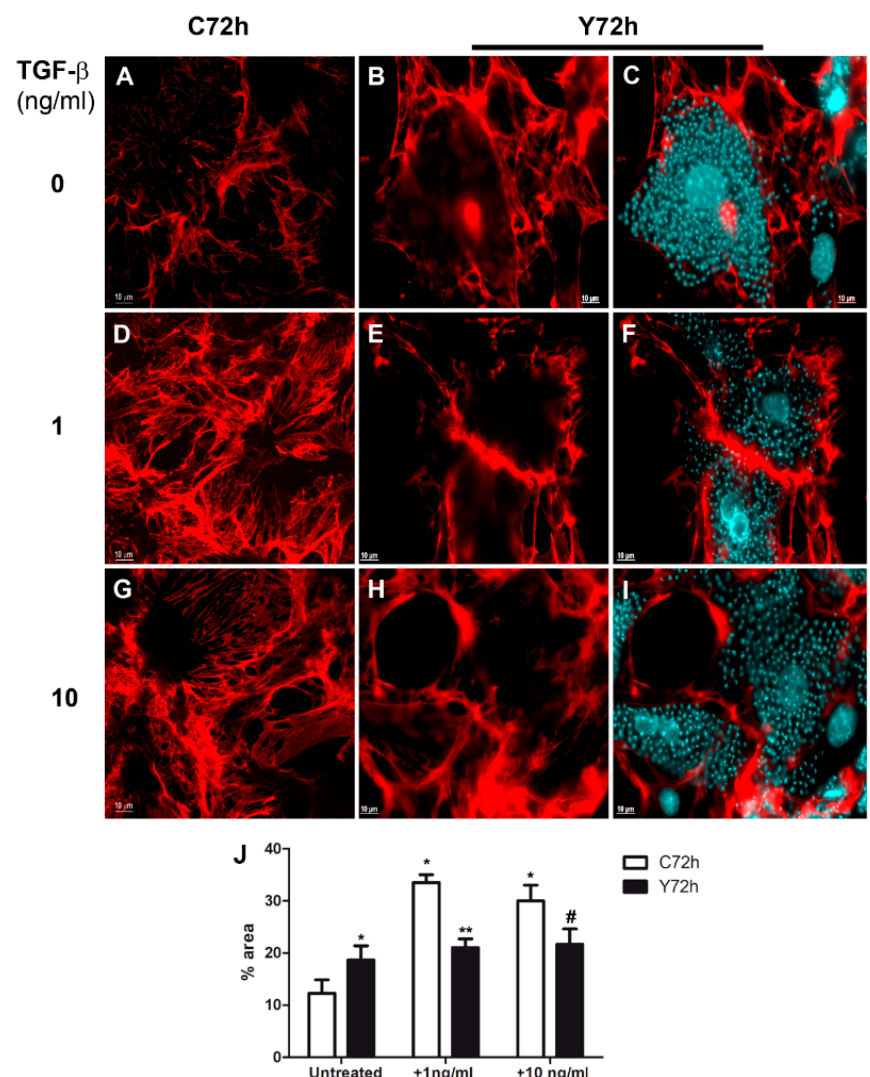
Figure 5. Distribution of fibronectin in cardiac fibroblasts infected with T. cruzi and treated with TGF- β . FN staining (red) in untreated T. cruzi infected CF ( B , C ) showed a general intensification of FN expression after 72 h of interaction, while highly infected cells presented a localized reduction when compared to uninfected controls ( A ). CF cultures showed higher FN expression after treatment with 1 ng / mL ( D ) and 10 ng / mL ( G ) of TGF- β . CF still displayed a localized reduction of FN staining in infected cells, even after TGF- β treatment (( E , F ) 1 ng / mL; ( H , I ) 10 ng / mL). ( J ) Quantification of FN fibril thickness by image processing with Image J software. DAPI (blue) was used to label the nucleus of the host cell and the kinetoplast of intracellular parasites. * p ≤ 0.05 vs. untreated, uninfected control (C72h); ** p ≤ 0.05 vs. uninfected + 1 ng / mL TGF- β ; # p ≤ 0.05 vs. uninfected + 10 ng / mL TGF- β . Bar = 20 µ m. The association of fibroblasts, the e ff ector cells of fibrosis, with relative down-regulation of FN expression in T. cruzi -infected cells after TGF- β stimulation led us to evaluate (in detail) the regulation of the signaling pathways involved in ECM modulation. We analyzed the activation profiles of PS2, phospho-p38 MAPK, and phosho-c-Jun signaling pathways in uninfected and T. cruzi -infected CFs (72 h) subjected (or not) to stimulation with 10 ng / mL of TGF- β . A 59% reduction in PS2 activation was evidenced in the infected CF cultures when compared to their uninfected counterparts (Figure